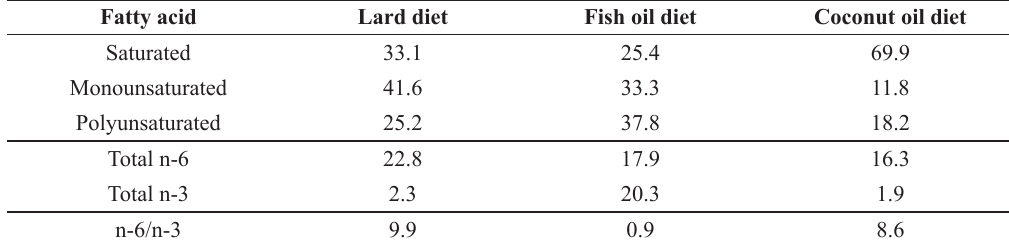
Table 2: Body, liver and perirenal fat tissue weights Week Group Final body weight (g)